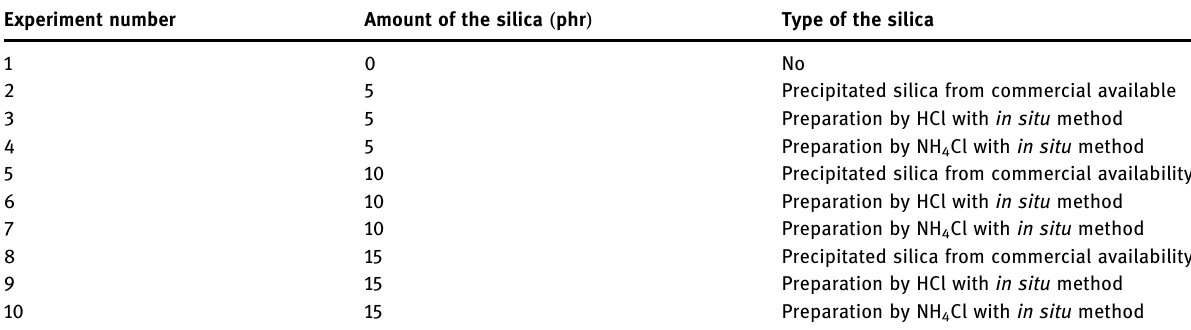
Table 2: Silica/NR composites experimental program Experiment number Amount of the silica ( phr